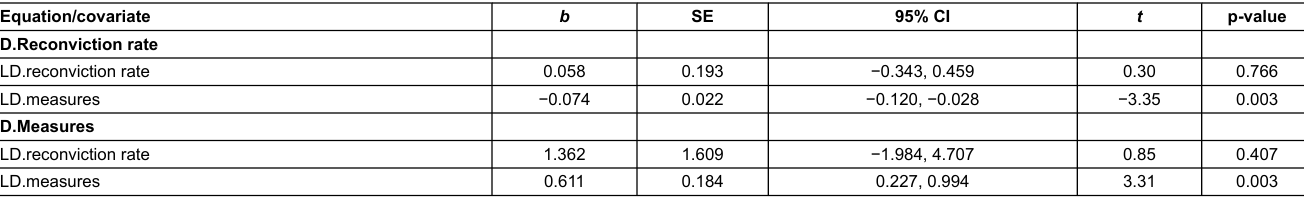
Table 1: Vector autoregressive model.